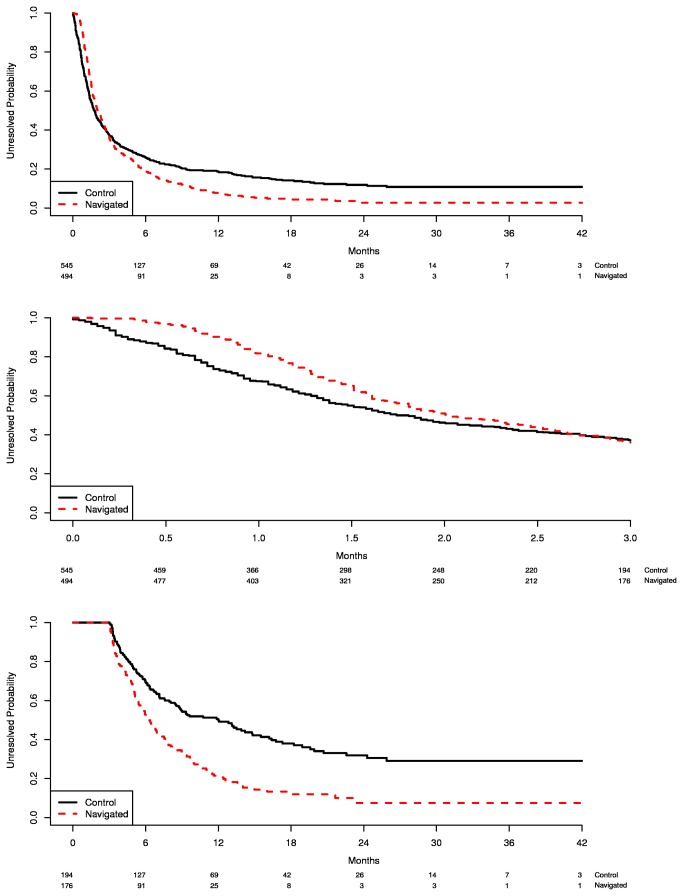
Kaplan-Meier estimates of time to diagnostic resolution: overall and 3 months cut-points.A: All patients across overall time period. B: Patients who resolved prior to 3 months. C: Patients who resolved beyond 3 months.